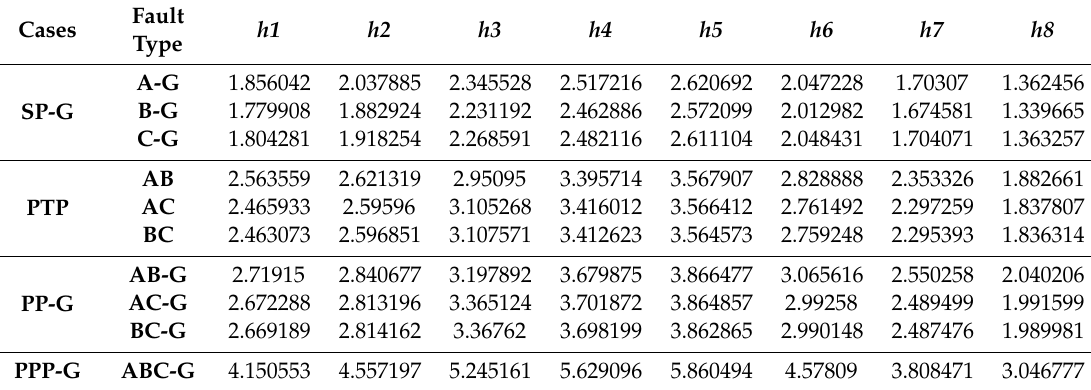
Table 2. The entropy values of di ff erent fault types with